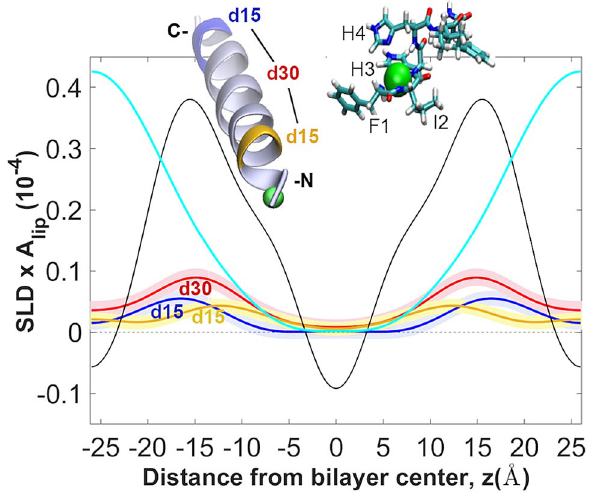
Figure 6. Positioning of P3-Cu 2+ in the bilayer with ND and deuterium contrast. The SLD profiles of two groups of specifically deuterated amino acids near the N-terminus (I 5 d10 F 6 d5 ; yellow) and C-terminus (F 19 d5 L 20 d10 ; blue) of P3 were obtained, as well as their sum (red) (Methods). Each profile represents time and ensemble averages of each of deuterated groups in the thermally disordered bilayer. The overall profiles for the neat POPC bilayer with P3-Cu 2+ (black) and the water distribution (blue) are overlaid on those for the deuterated groups. Measurements were done at P/L = 1:25, 23 °C, and 93% relative humidity. Uncertainty bands in the deuterium profiles (colored bands) were determined using a 68% confidence interval in the Monte-Carlo sampling of the measured structure factors 87 . The inset show representative average conformation of the P3 α-helix in the bilayer, using a 3D structure derived from the NMR structure (PDB ID # 6PEZ) 58 and the predicted structure of the Cu 2+ -bound ATCUN motif based on density functional theory calculations 64 . The orientation of the